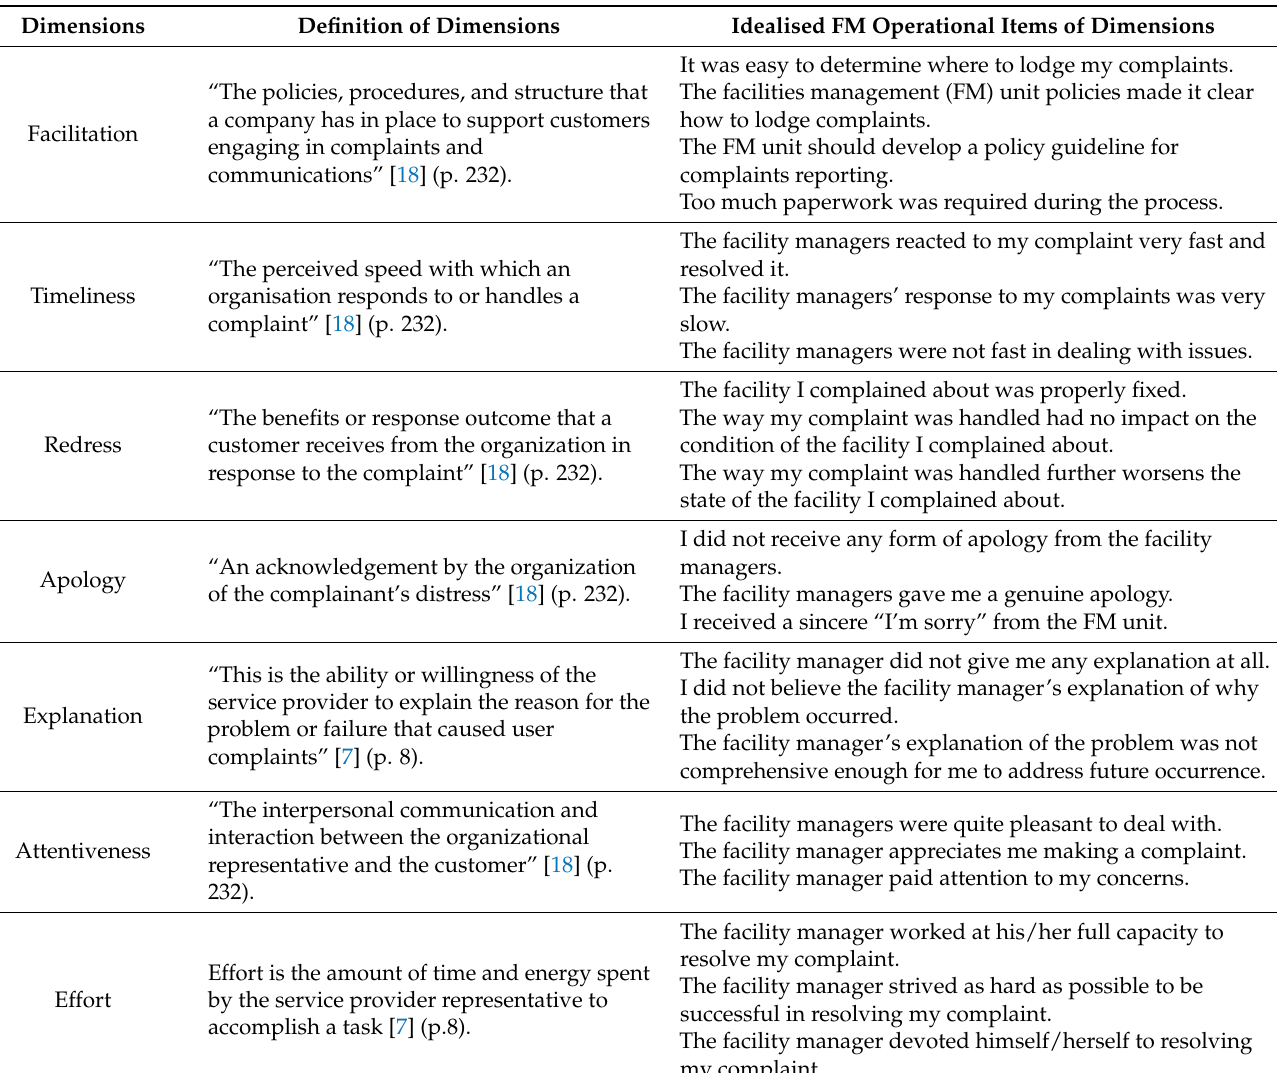
Table 1. Core responses dimensions to user